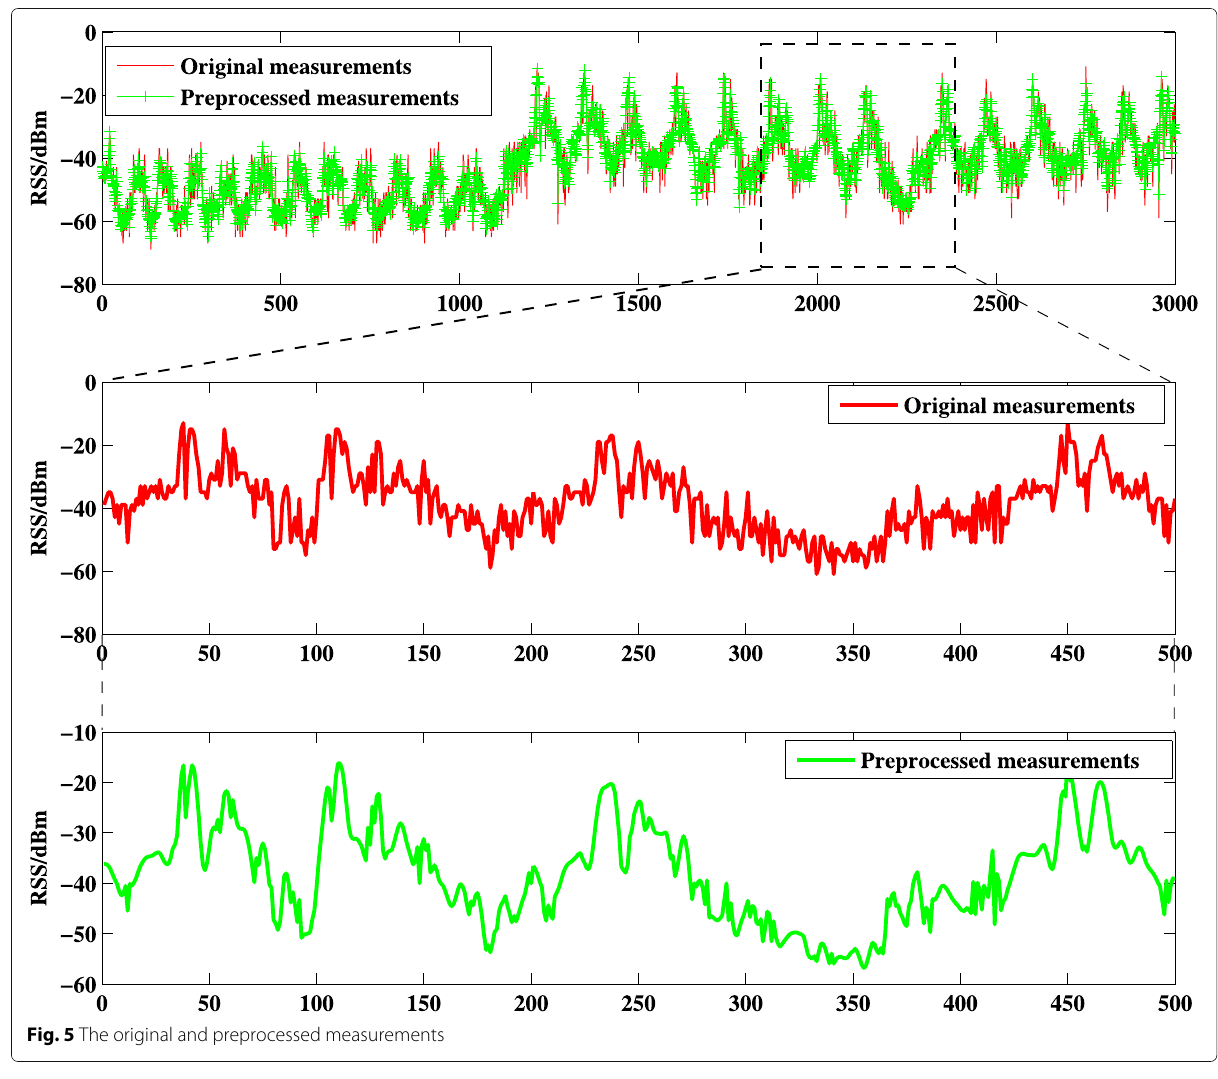
Fig. 5 The original and preprocessed measurements